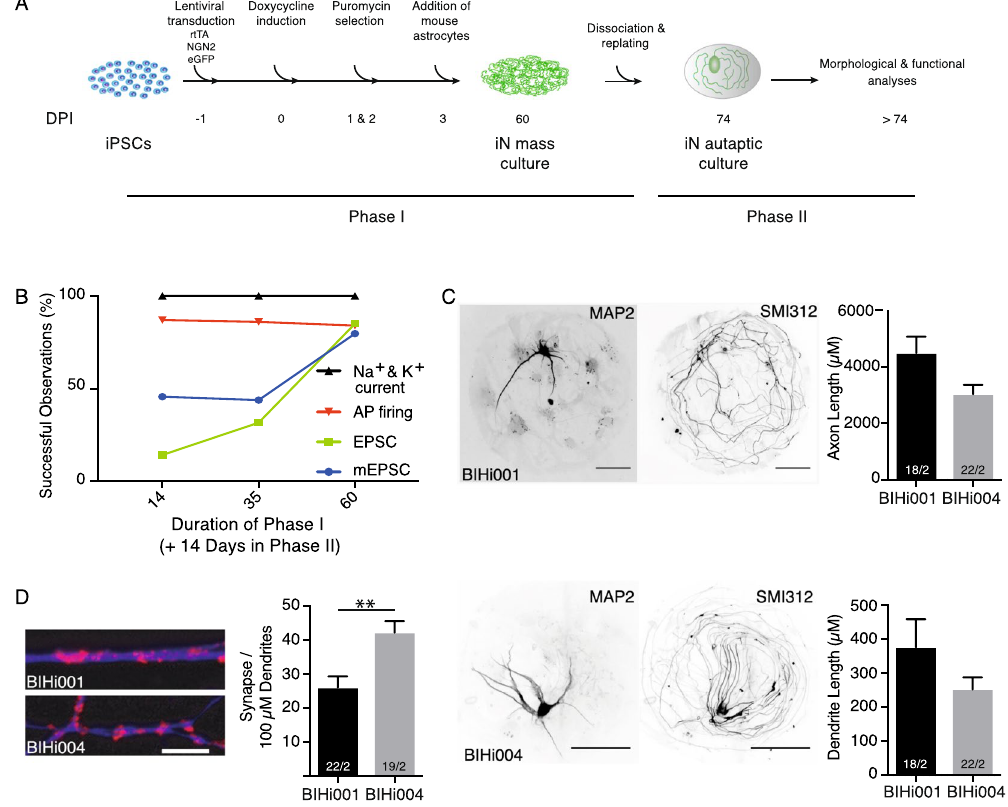
Figure 1. Human neurons in autaptic culture. ( A) Schematic diagram of the autaptic culture protocol for hiNs. IPSCs were plated and infected with Ngn2, rtTA and eGFP on day − 1, followed by application of doxycycline to start Ngn2 expression and puromycin selection on day 0 to 3. HiNs were co-cultured with mouse astrocytes for 60 days, followed by dissociation with Accutase and replating onto astrocytic microislands. Single autaptic iNs were analysed after 14–21 days. ( B) Quantification of electrophysiological recordings of autaptic iNs replated on microislands after 14, 35 or 60 days post induction (DPI) in the mass-culture phase, followed by another 14–21 days of cultivation on microislands. ( C) Representative images and quantification of total axonal and dendritic lengths of human autaptic iNs. Dendrites were identified by MAP-2 staining and axonal processes were stained with SMI-312. Images in each row belong to the same iN lines. Scale bars: 50 µ m. ( D) Example images and quantification of synapse density in human autaptic iNs. Synapses were identified by Synaptophysin labelling. Only synaptophysin punctae (red) on top of MAP-2 staining (blue) were counted. Scale bars: 5 µ m. The numbers of neurons and independent cultures analysed are shown within the bars. Data are expressed as mean ±